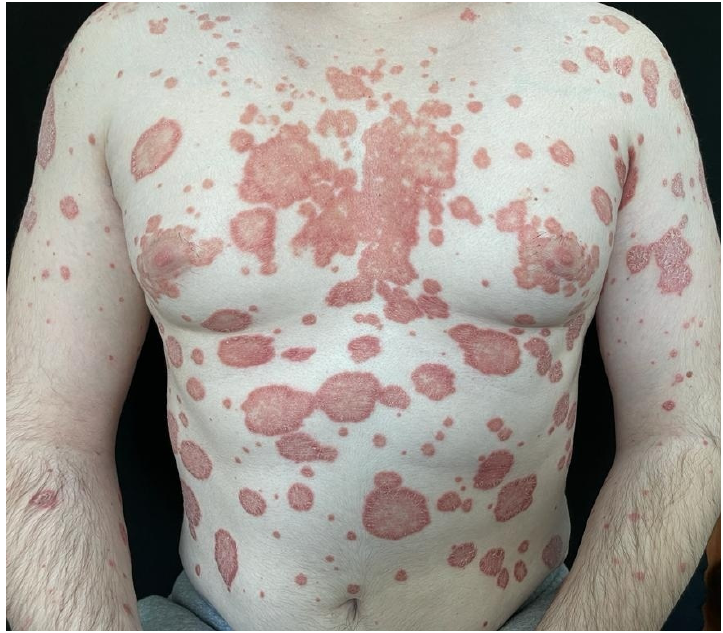
Figure 2. Chronic plaque psoriasis with extensive skin involvement on the anterior aspect of the trunk and on the upper limbs.